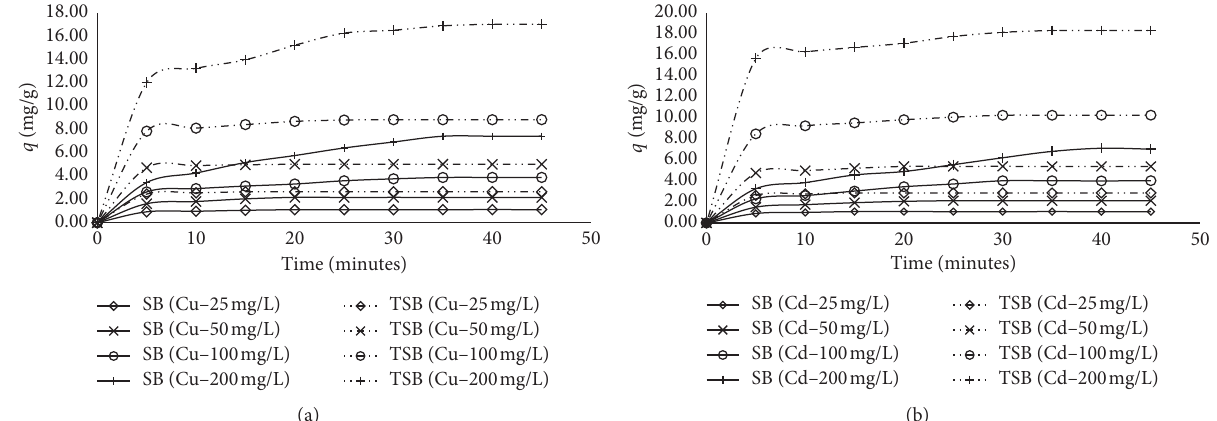
Figure 4: pH effect on the removal of Cu(II) and Cd(II).